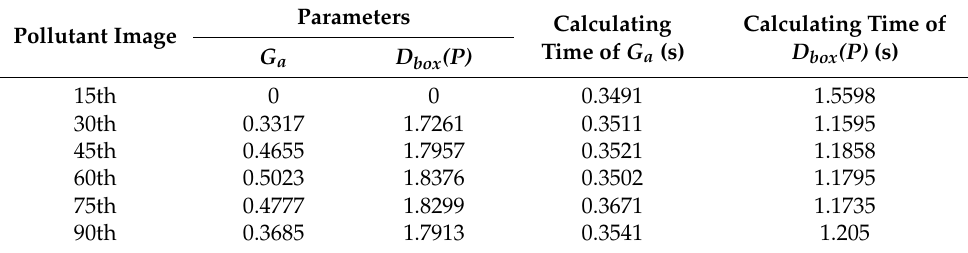
Table 2. Calculation results of fractal dimension and grayscale average for partial pollutant images. Pollutant